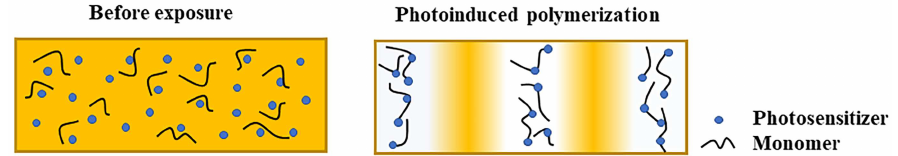
Figure 5. The process of photopolymerization for the formation of holographic recording gratings.